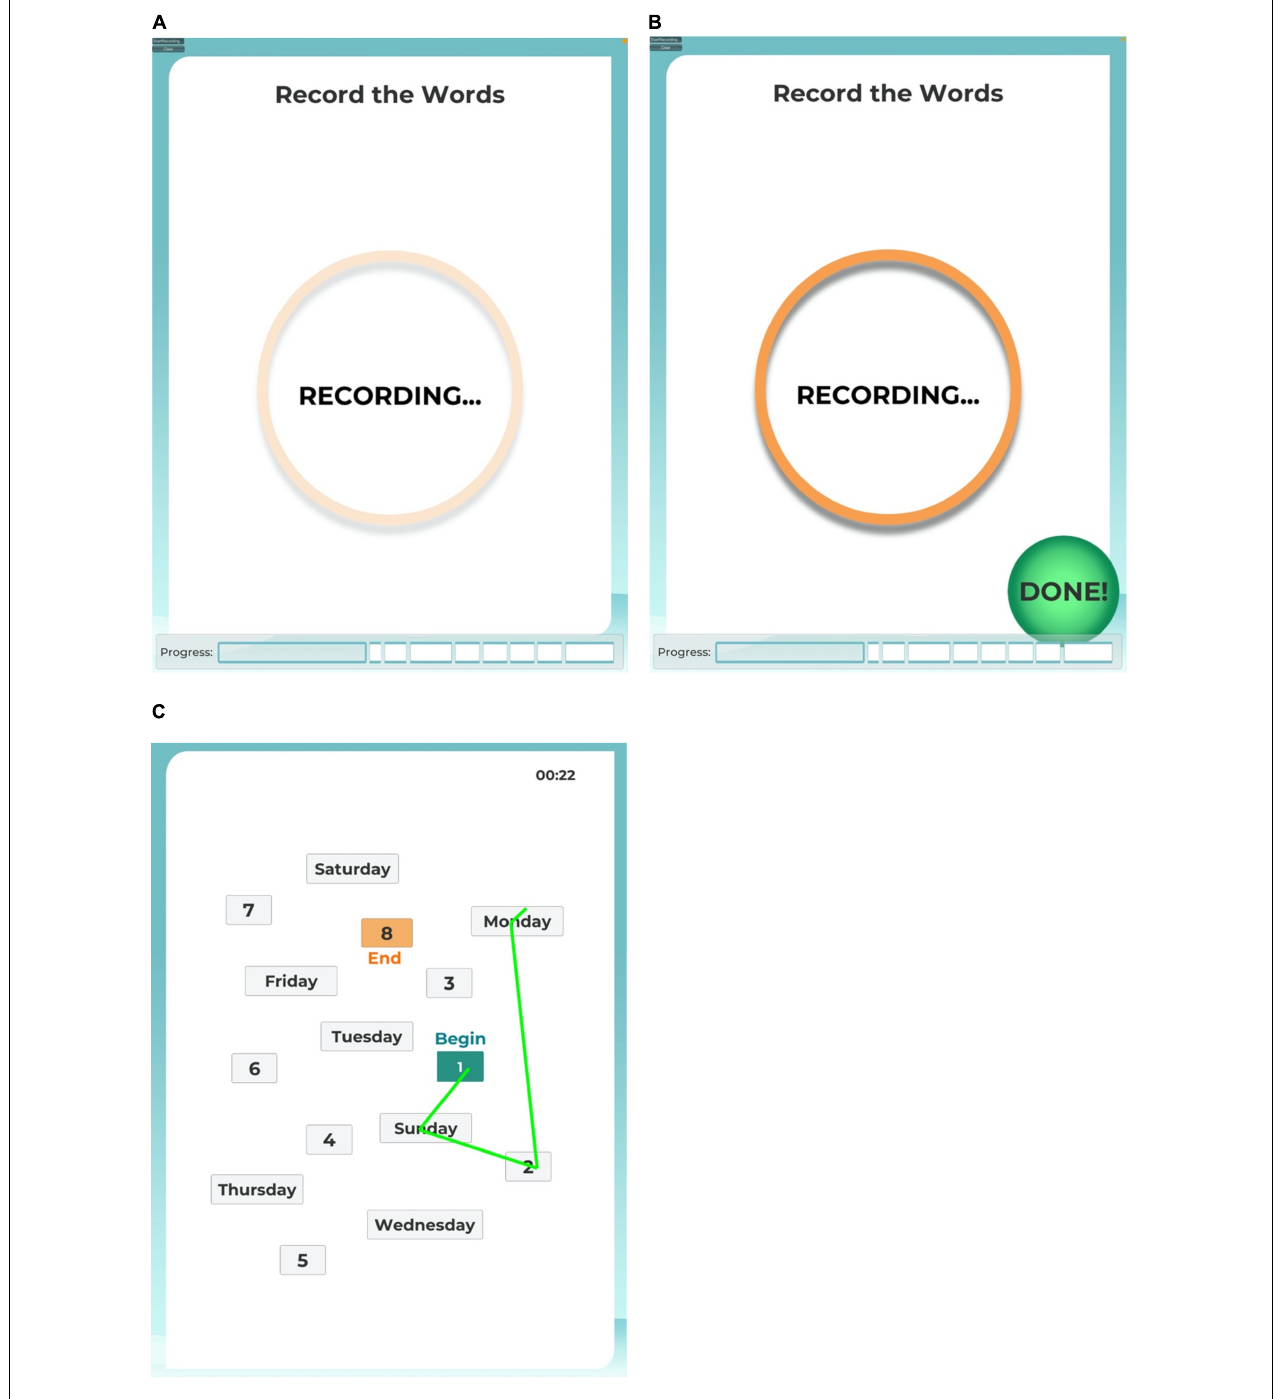
FIGURE 1 | iPad screen images. The user interface provided participants with an animated recording reminder during the active task sessions (A) and a control button to end a task session before the time limit (B) . For task 8, the user interface provided participants with a map of numbers and days of the week to connect by drawing a line with their finger tip (C)